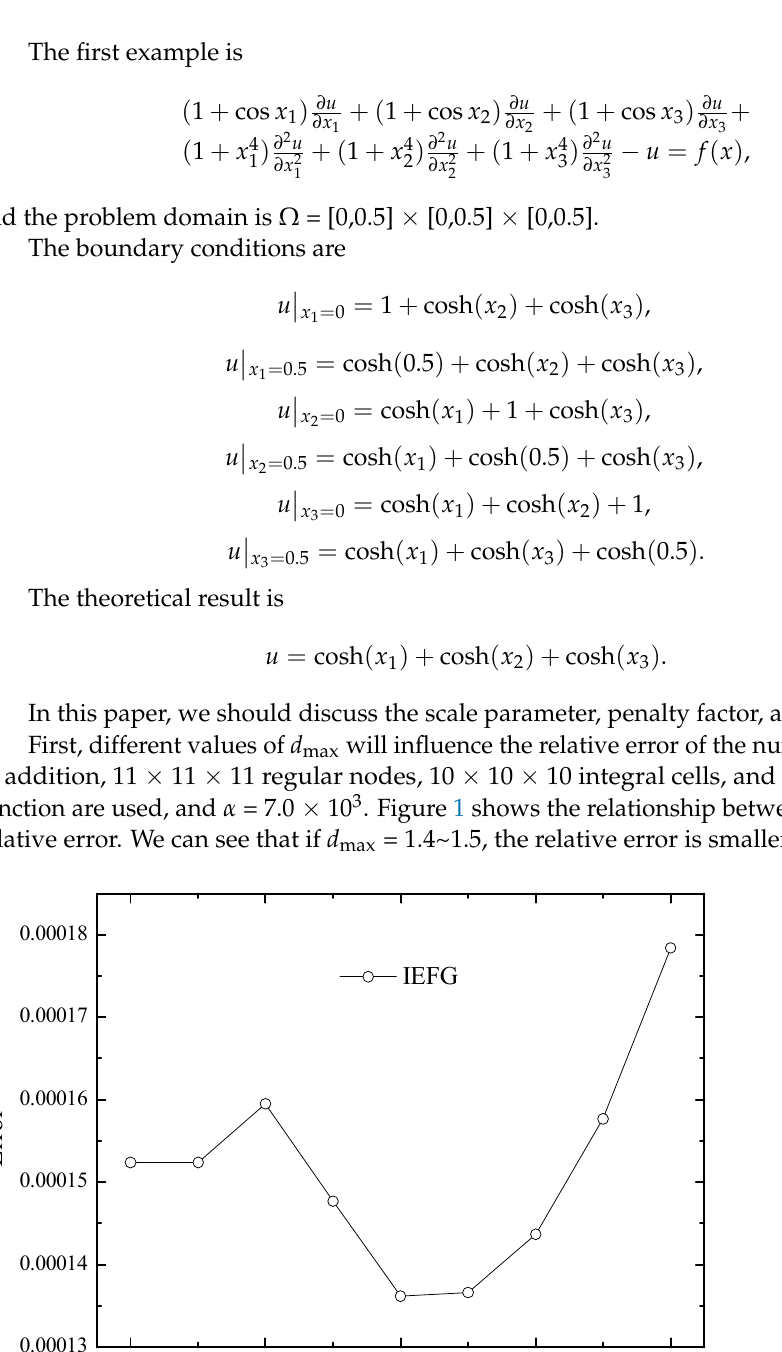
Figure 2. The relationship between α and the relative error. In order to demonstrate the convergence of the IEFG method, the distribution of nodes must be discussed. d max = 1.44, α = 7.0 × 10 3 , and the cubic spline function is used. Table 1 shows the relationship between the node distribution and the relative errors. It is easy to see that with increase in nodes, the relative error shows a decreasing trend. Figure 3 shows the contour plot of nodes, numerical solutions, and the relative errors.